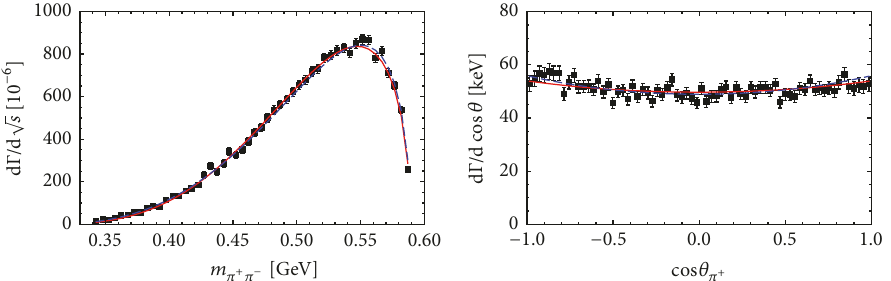
Figure 1: Simultaneous fit to the 𝜋𝜋 invariant mass distributions and the helicity angle distributions in 𝜓 耠 󳨀→ 𝐽/𝜓𝜋 + 𝜋 − . The red solid and blue dashed curves represent the theoretical fit results with 𝜋𝜋 FSI and without 𝜋𝜋 FSI cases, respectively. The data are taken from [37].